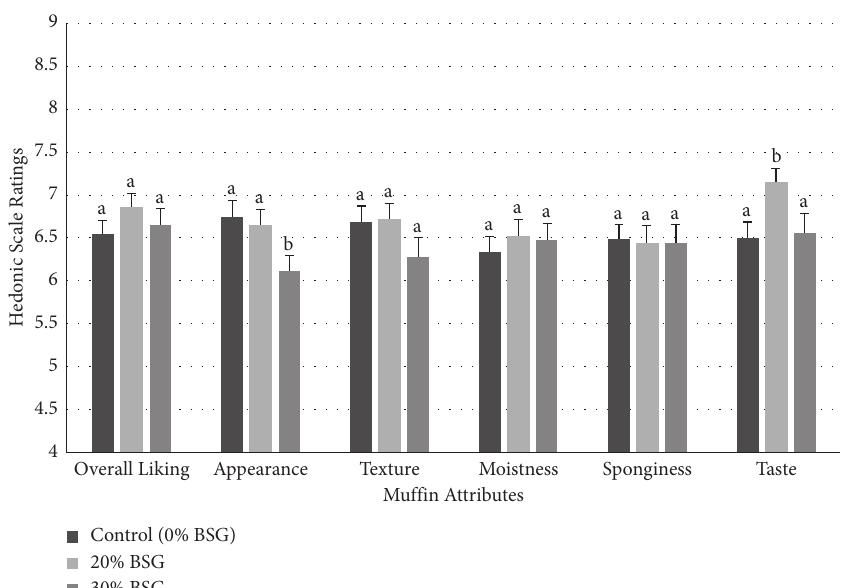
Figure 2: Mean hedonic ratings for muffins containing different percentages of brewers’ spent grain. Mean consumer test ratings of muffin attributes for 0%, 20%, and 30% BSG muffins from one-way repeated measures MANOVA. Bars with different superscripts under the same attribute are significantly different ( n � 107; P < 0.05, Tukey’s honestly significant difference test). 1 � dislike extremely; 5 � neither like nor dislike; 9 � like extremely. Error bars indicate standard error of the mean